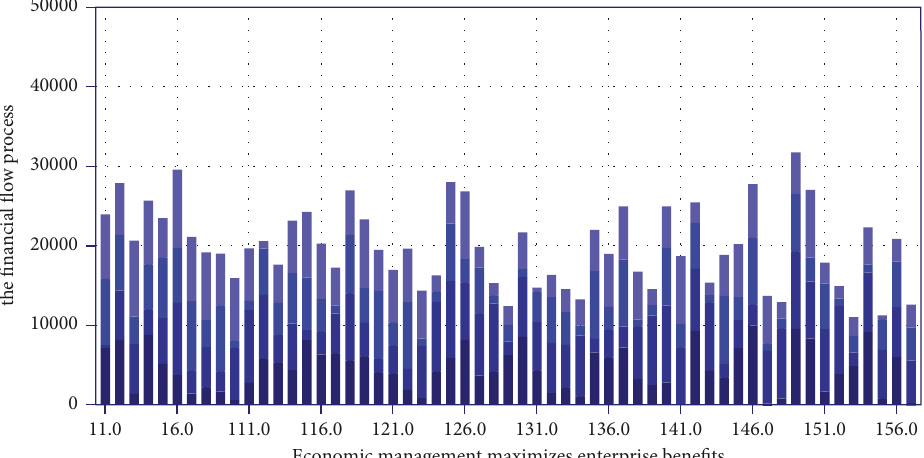
Figure 10: The results of economic management maximizing enterprise